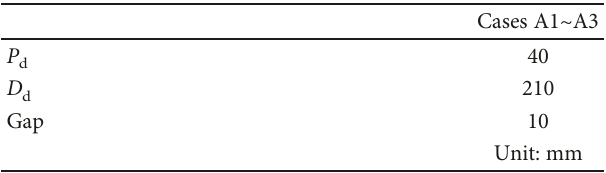
Figure 1: Schematic diagram of the 250 kgf class DVF engine. (a) XY plane cross section. (b) YZ plane cross section. Table 1: Dimensions of the 250kgf class DVF